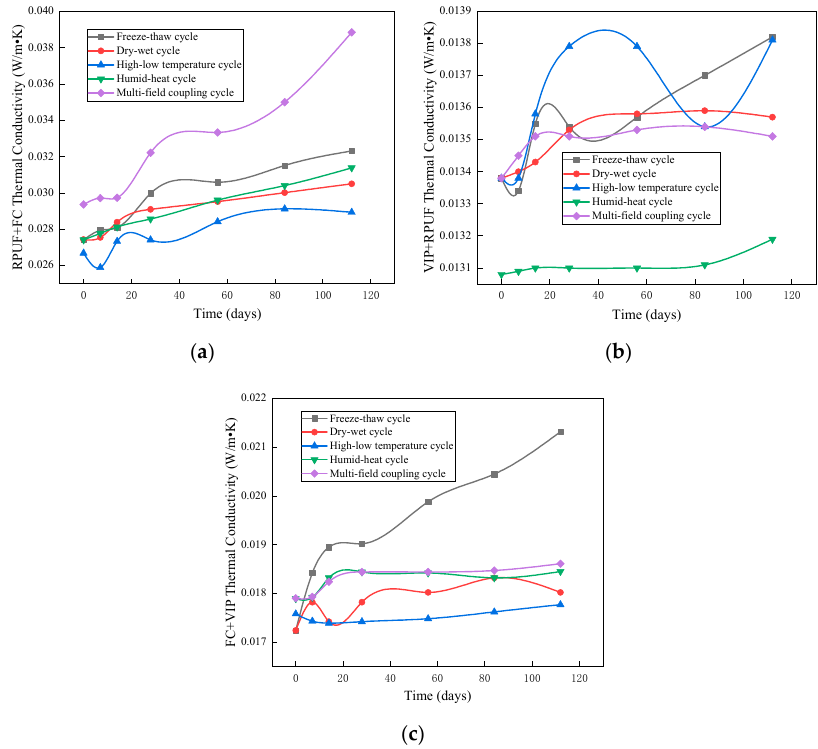
Figure 7. Changes in thermal conductivity of composite materials in weathering resistance tests: ( a ) foam concrete (FC) and rigid polyurethane foam composite (RPUF), ( b ) vacuum insulation panels (VIP) and RPUF, and ( c ) VIP and FC.